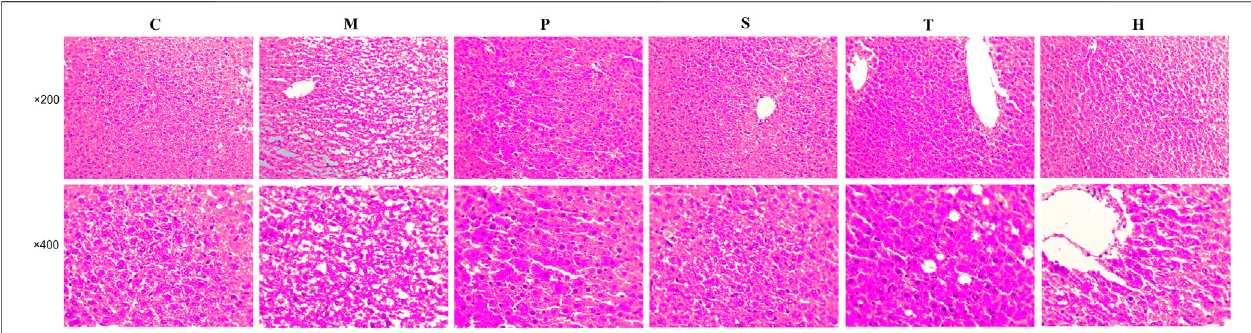
Frontiers in Pharmacology |